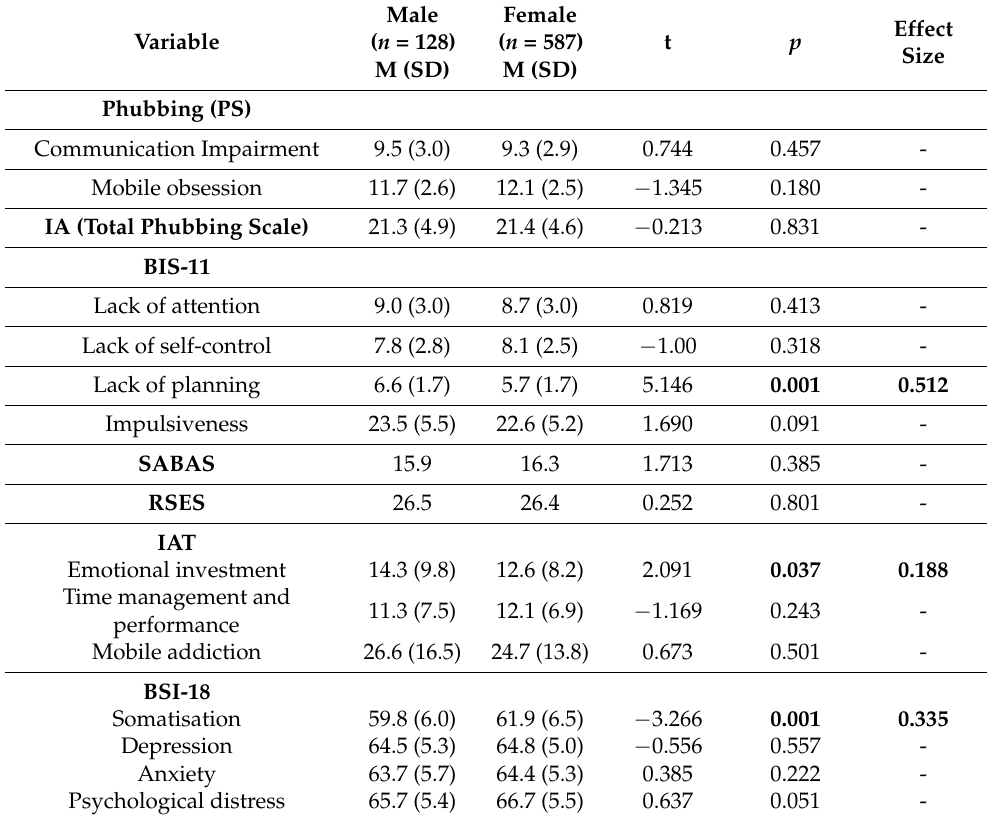
Table 4. Internet addiction scores in men and women ( n = 715).